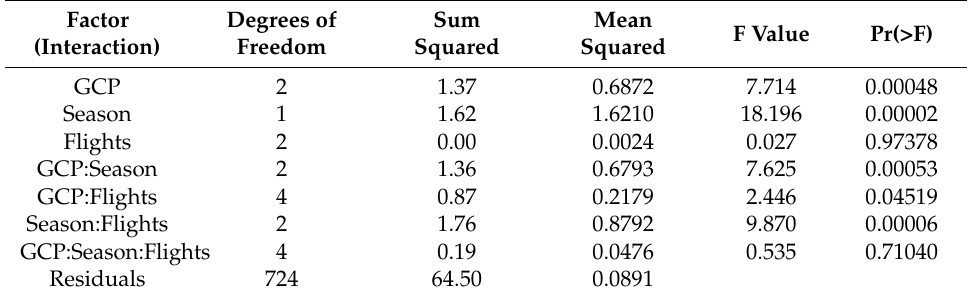
Table 10. Results of the three way factorial ANOVA for vertical accuracy. Evaluated factors: georectification method (GCP), flight pattern, vegetation season; and their